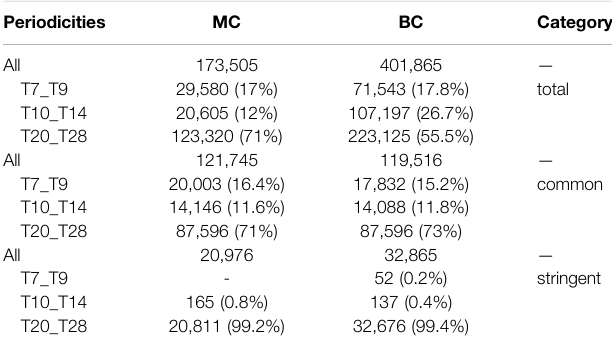
TABLE 1 | Number and relative proportion of oscillating transcripts, calculated for each method and tested periodicities.